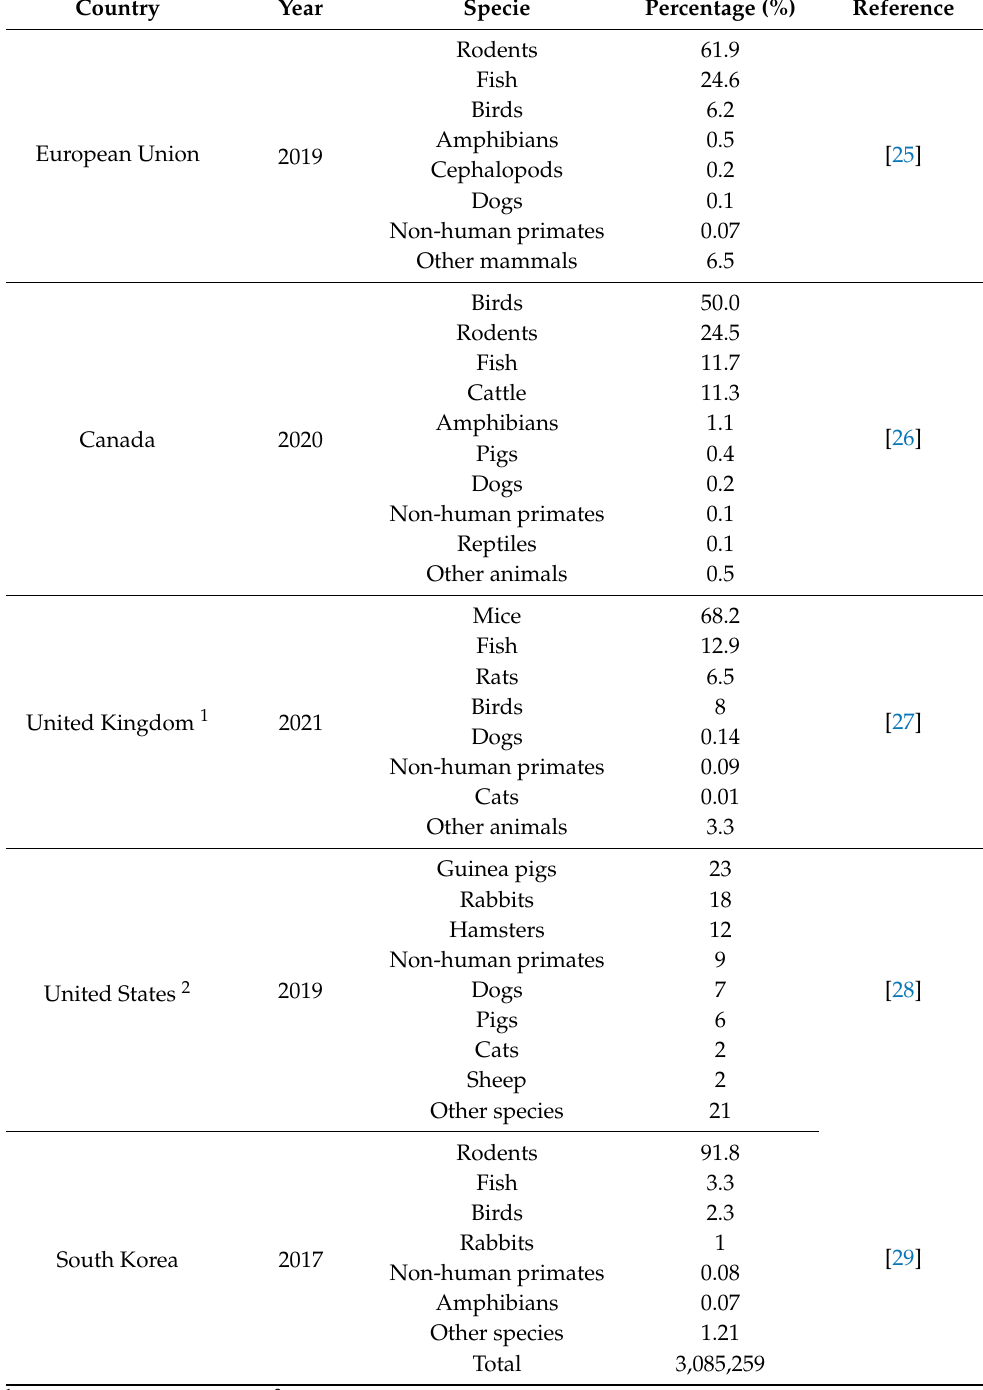
Table 1. Overview of the number of animals used in research, according to the species.